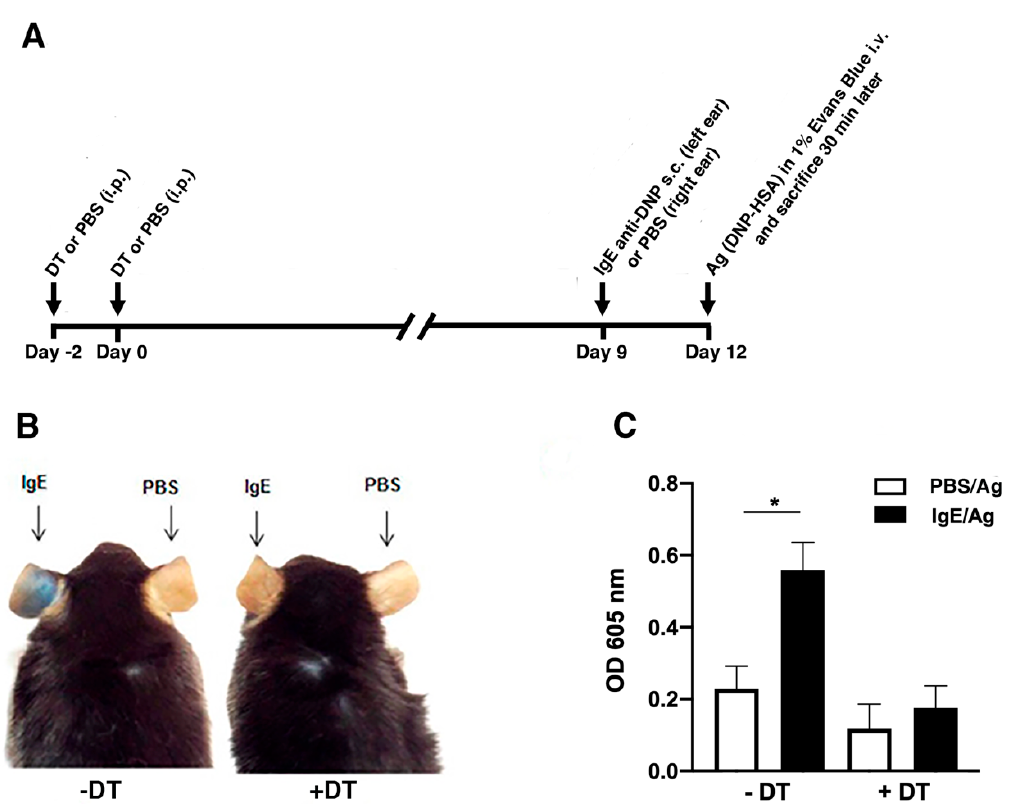
Figure 2. Passive cutaneous anaphylaxis reaction is impaired after conditional ablation of mast cells. ( A ) Schematic diagram of the protocol of the PCA experiment as performed in B. RMB mice were treated or not with 2 DT injections i.p. (1 µg) at day -2 and day 0. Then mice were passively sensitized s.c. with 100 ng anti-DNP IgE (left ear) or with PBS (right ear) at day 9. Three days later, mice were challenged i.v. with Ag (DNP-HSA, 150 µ g) in 1% Evans blue in PBS (final volume 150 µ L) and mice were sacrificed 30 min later. ( B ) Photomicrographs of dye extravasations of representative mice submitted to a PCA experiment according to the protocol depicted in A. IgE-sensitized ears of non DT treated (-DT) mice exhibited dye extravasation in the skin after Ag challenge, while DT treated (+DT) mice (MC-depleted and basophil repleted at day 12) had only minimal signs of ex- travasation in IgE-sensitized ears, comparable to PBS-sensitized ears of (-DT) and (+DT) mice. ( C ) Quantification of Evans blue extracted from ears of mice in corresponding experiments is shown. Number of mice correspond to 4 mice per condition. Statistical analysis was based on an unpaired t-test (* p < 0.05) between groups.